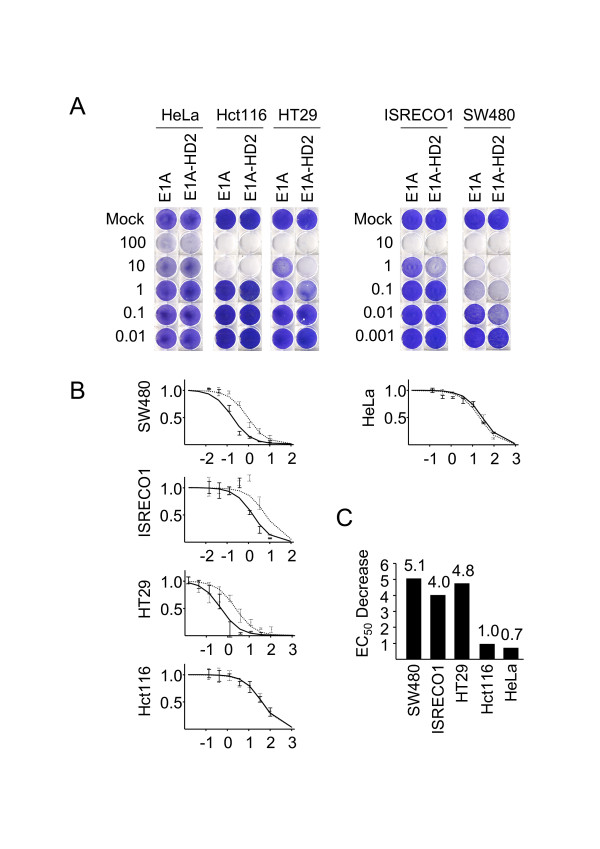
The E1A-HD2 virus shows increased toxicity on cells with activated Wnt signaling. A. CPE assays. Cells were infected with 10-fold dilutions of virus starting from 100 pfu/cell in HeLa, Hct116 and HT29 cells, and starting from 10 pfu/cell in ISREC-O1 and SW480 cells. B. MTT assays in the same cell lines. Dotted line, parental virus. Solid line, E1A-HD2 virus. C. The change in EC50 calculated from the data in B.